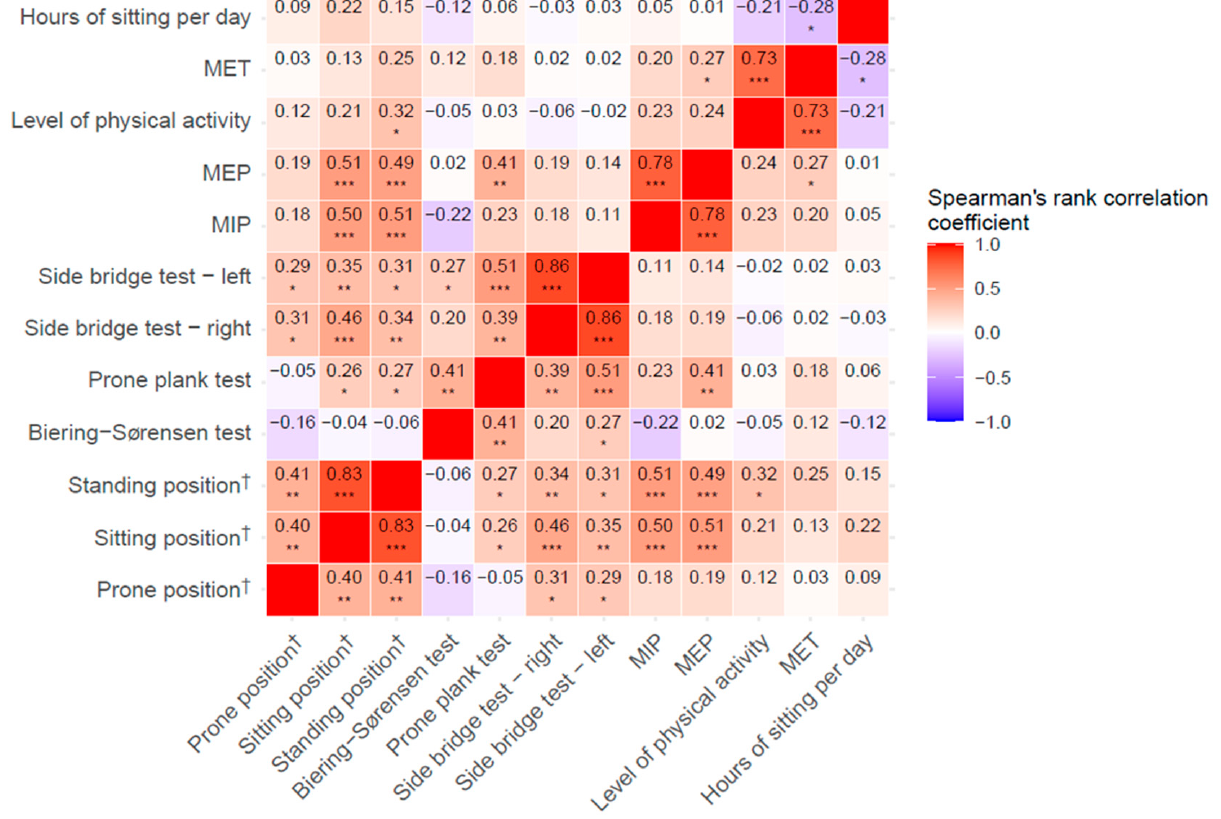
Figure 2. Correlation between strength testing procedures, muscular endurance tests, and IPAQ. Significance of correlations is expressed through asterisks at levels as follows: * p < 0.05, ** p < 0.01, and *** p < 0.001. † Maximal isometric lower back extensor strength in different positions.